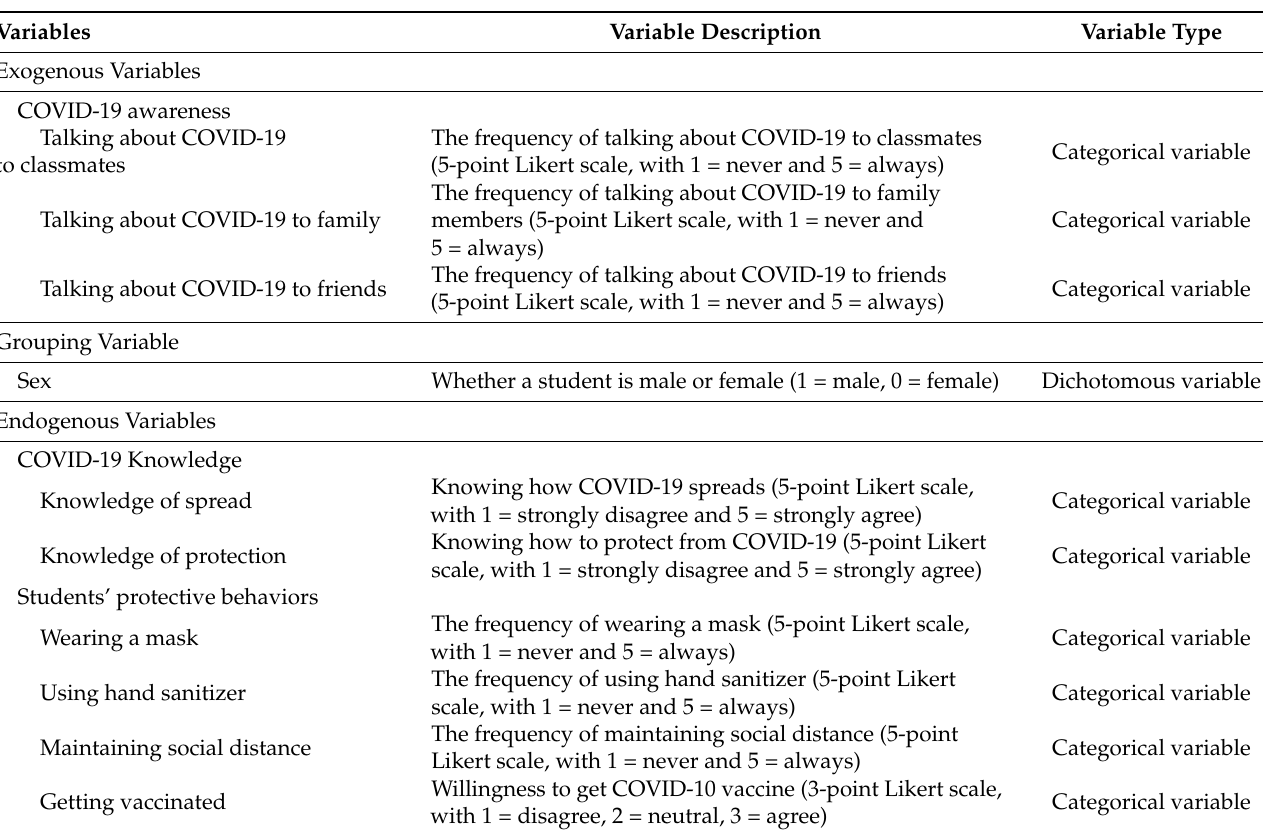
Table 1. Description of